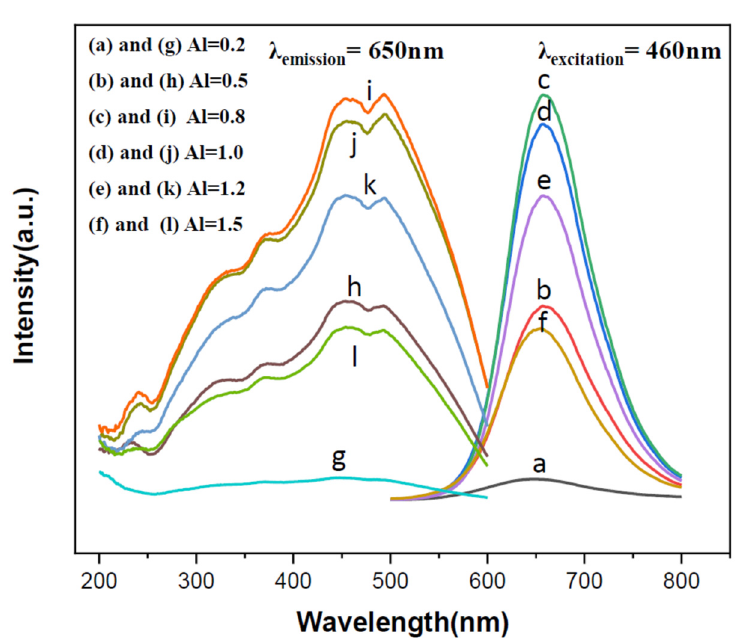
Figure 6. The emission ( a – f ) and excitation ( g – l ) spectra of the phosphors synthesized in this study.